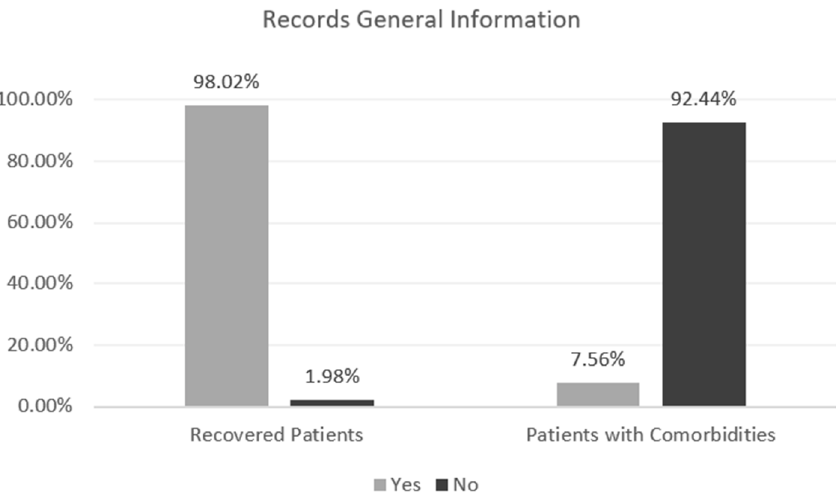
Figure 2. Records General Information.